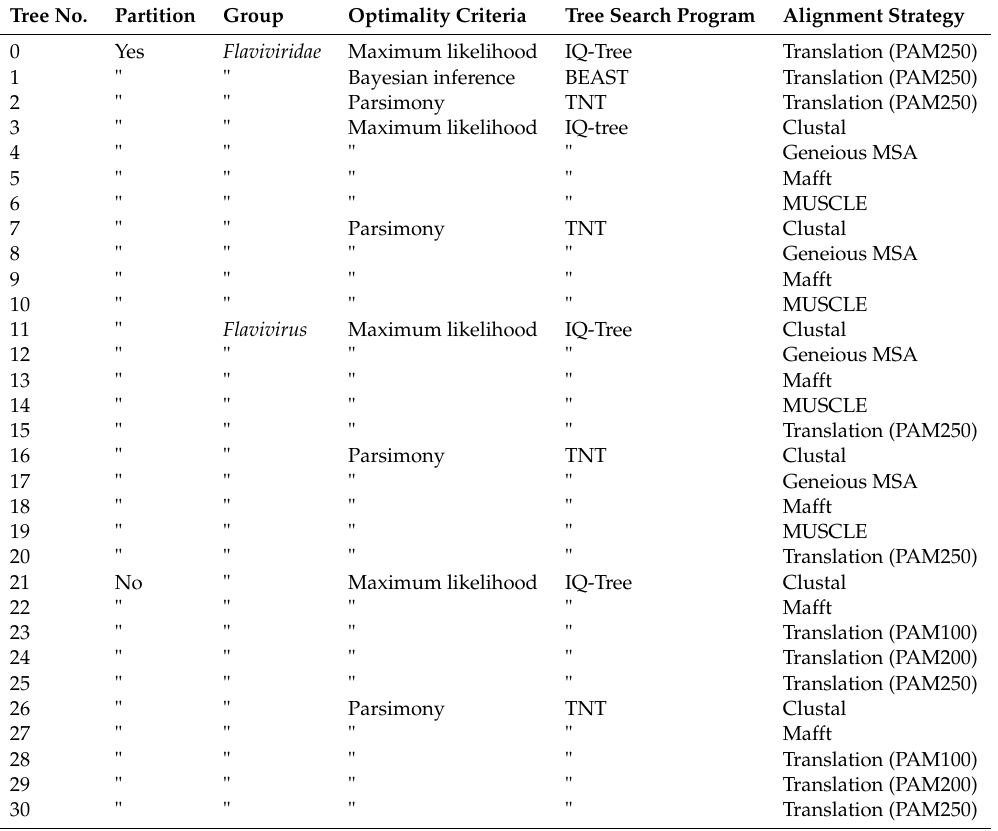
Table 1. Enumeration of different tree search strategies. “Translation” and “Geneious MSA” indicates the translation-based alignment tool and the multiple sequence alignment tool provided in Geneious v8.1.9, respectively. The ditto mark (") indicates values that are the same as the above. Tree